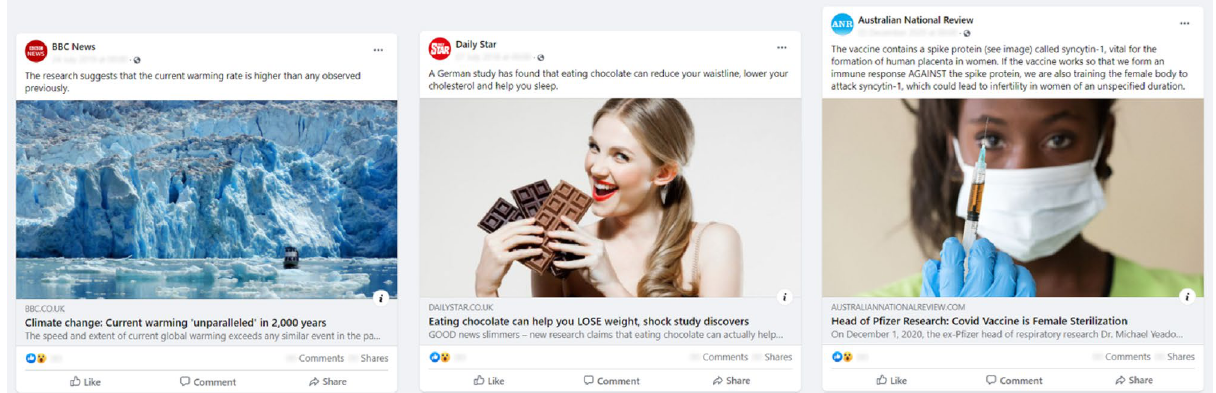
Figure 2. Examples of the stimuli presented, varying in topic (Climate Change, Health and Nutrition, COVID- 19), factual reporting (high, low, low), scientific validity (high, low, low), and source reputation (trusted, untrusted, unknown